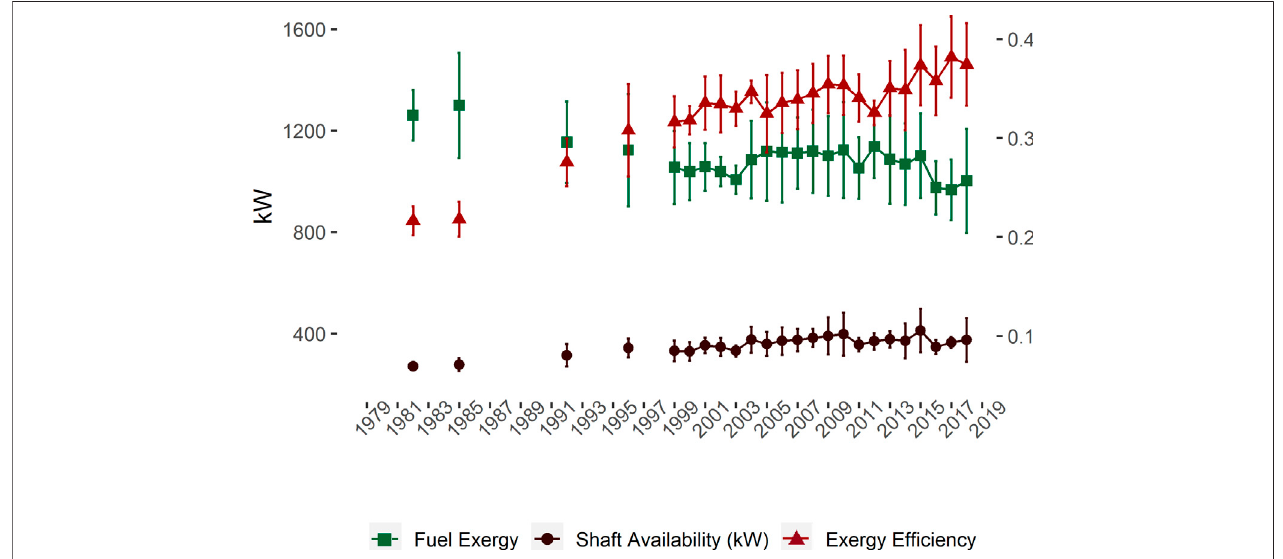
FIGURE 3 | Breakdown of exergy ef fi ciency in fuel exergy and power, heavy-duty trucks. Indicated with dots: fuel exergy (or availability of fuel supplied, Eq. 1 , measured in kW); with triangles: power availability at shaft (left-hand axis , measured in kW); with squares: exergy ef fi ciency as measured as the ratio between the two (right-hand axis)